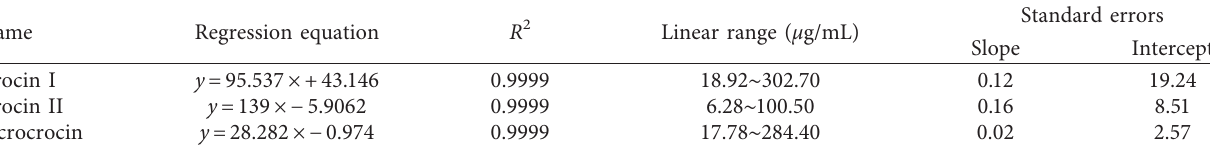
Table 2: The regression equation, R 2 , linear range, and standard